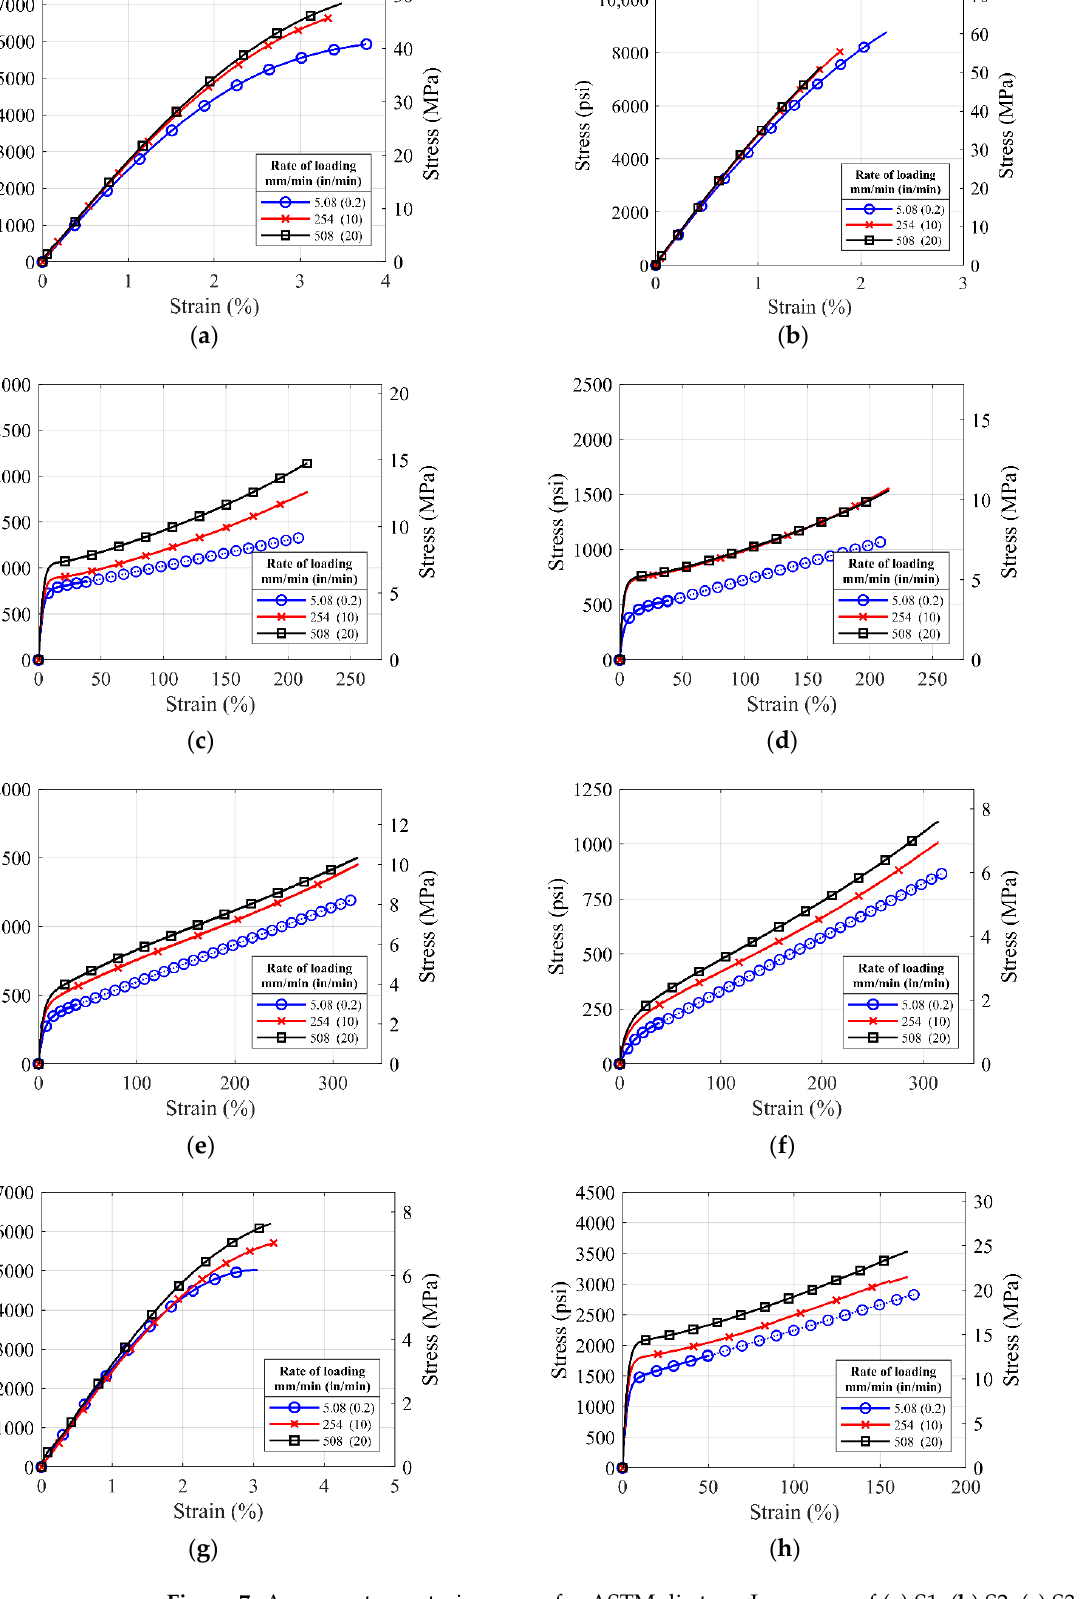
Figure 7. Average stress-strain curves for ASTM die type I coupons of ( a ) S1, ( b ) S2, ( c ) S3, ( d ) S4, ( e ) S5, ( f ) S6, ( g ) S7, and ( h ) S8 material tested with loading rates of 0.2 in/min, 10 in/min and 20 in/min.